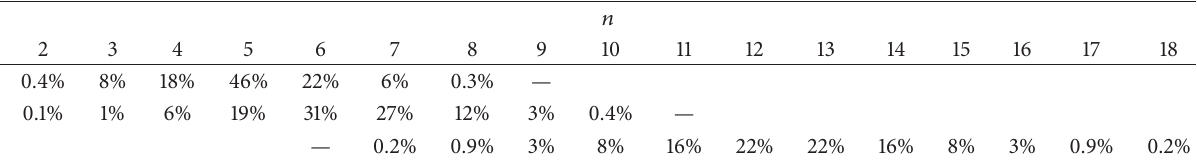
(𝑛) is the 𝑄𝑄 → 𝑛𝐺 1(2)